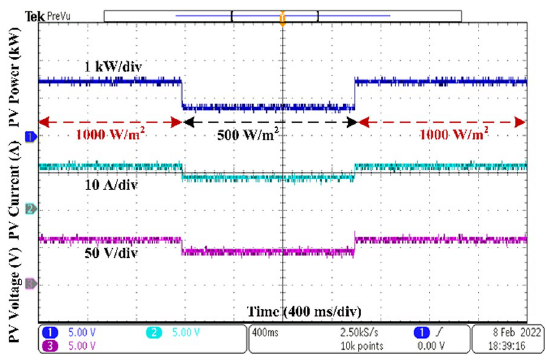
Fig. 25 PV voltage, power and current response for the proposed method in the presence of changing radiation